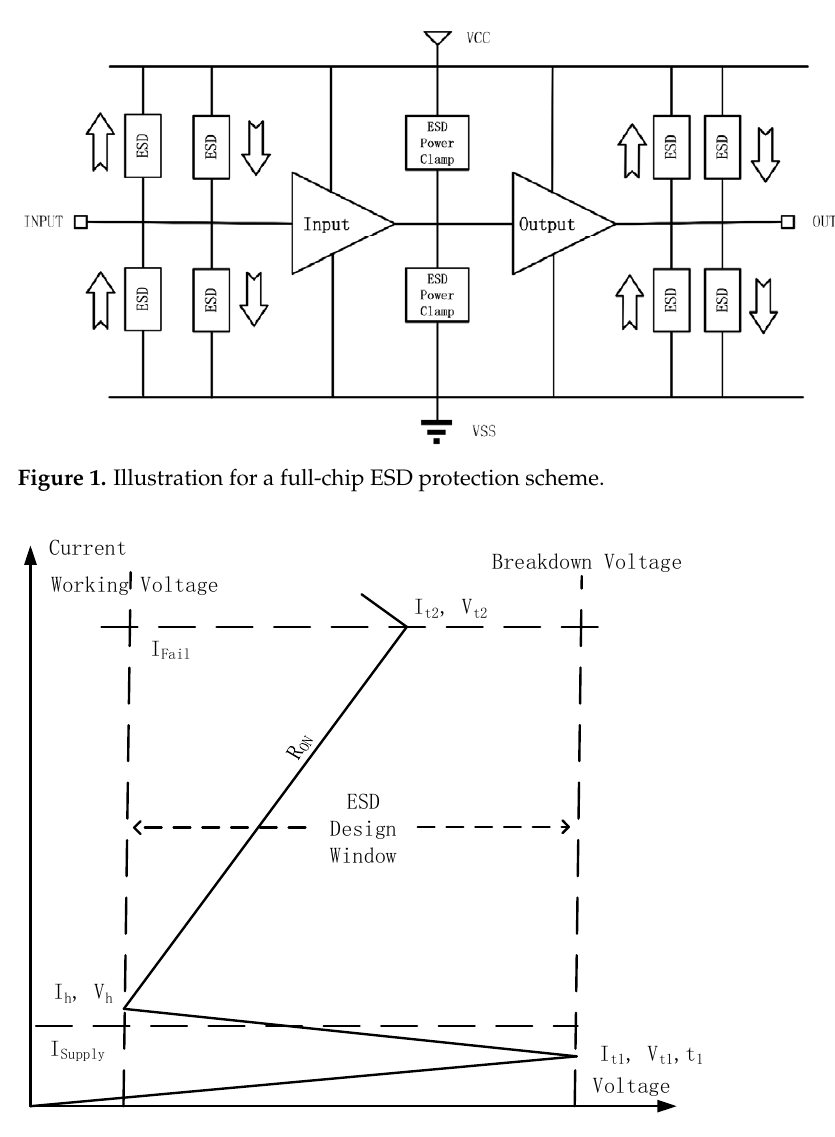
Figure 2. Typical ESD I–V characteristics and ESD design window.